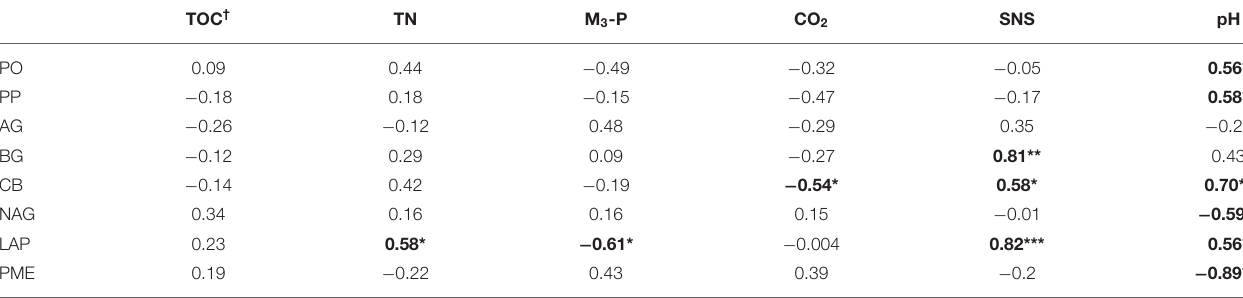
TABLE 7 | Correlation coefficients between extracellular enzyme activities and soil properties using overall means from all study sites.